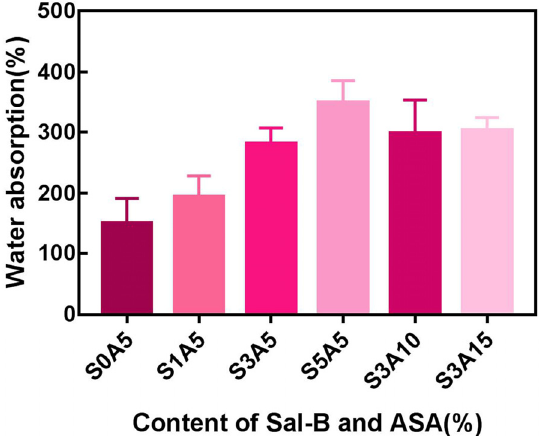
Figure 5. Water absorption of the dual drug ‐ loaded biomimetic composite scaffold.